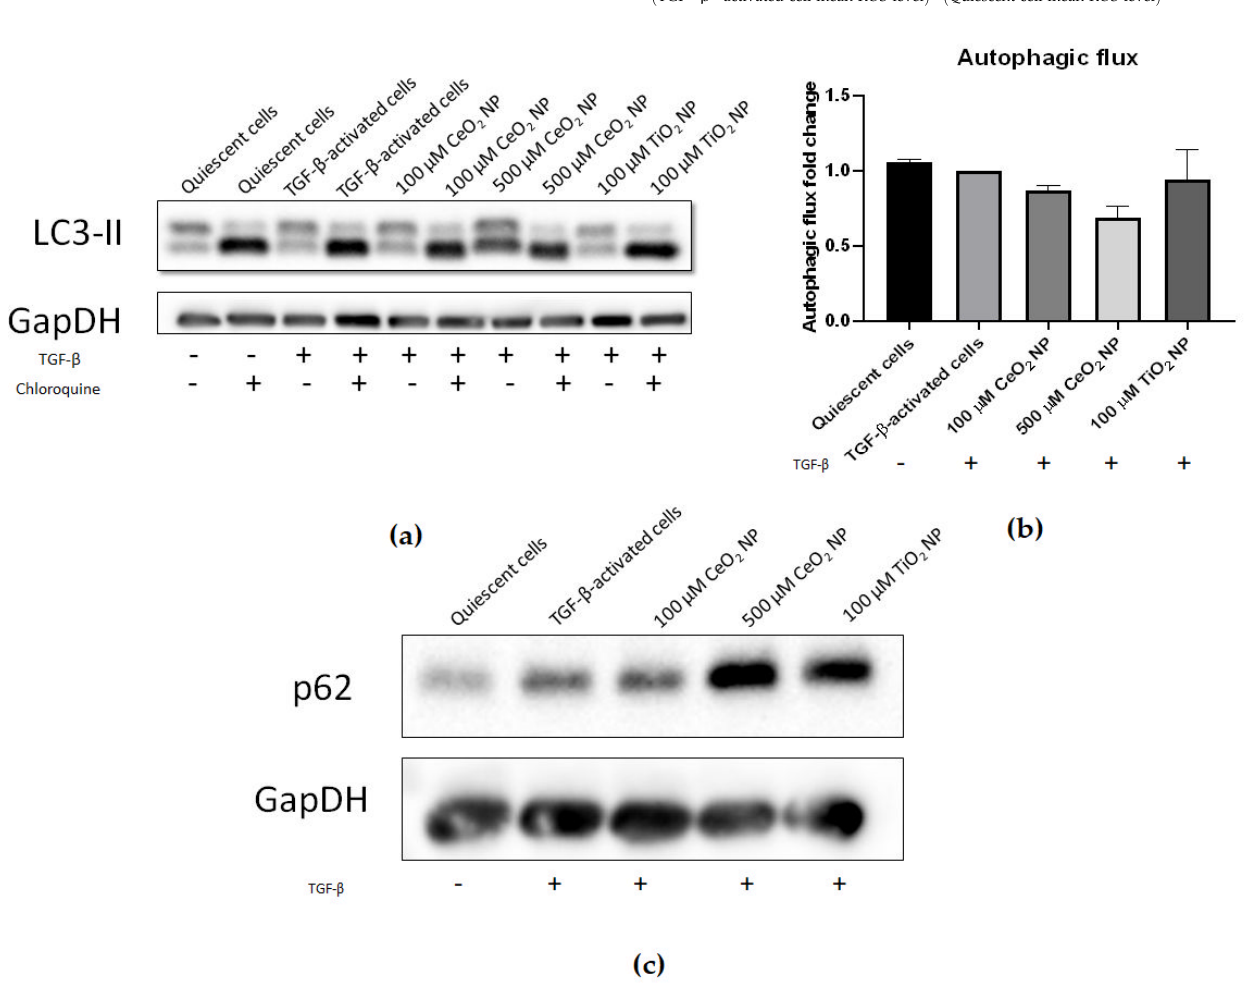
Figure 5. Autophagy is potentially reduced in CeO 2 NP-treated cells. ( a ) Immunoblots of LC3-II expression in CeO 2 NP-treated cells with and without the autophagy inhibitor chloroquine. ( n = 4) ( b ) The 100 µM and 500 µM CeO 2 NP showed reduced autophagic flux in a dose-dependent manner when calculated using the ratio of LC3-II expression in chloroquine-treated and chloroquine-untreated cells and measured using densitometry analysis ( n = 4). ( c ) p62 expression was increased in 100 µM and 500 µM CeO 2 NP-treated cells when investigated using immunoblotting ( n = 5) . Error bars represent SEM; ANOVA was used to calculate significance.